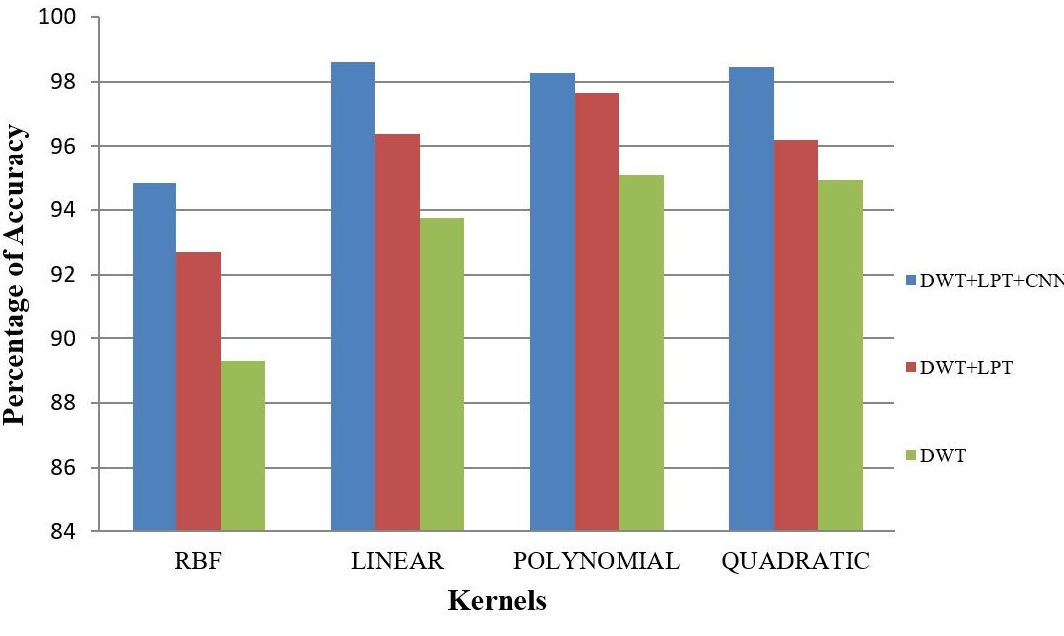
Figure 11. Average Accuracy for Abnormality Detection of T-1 weighted images.